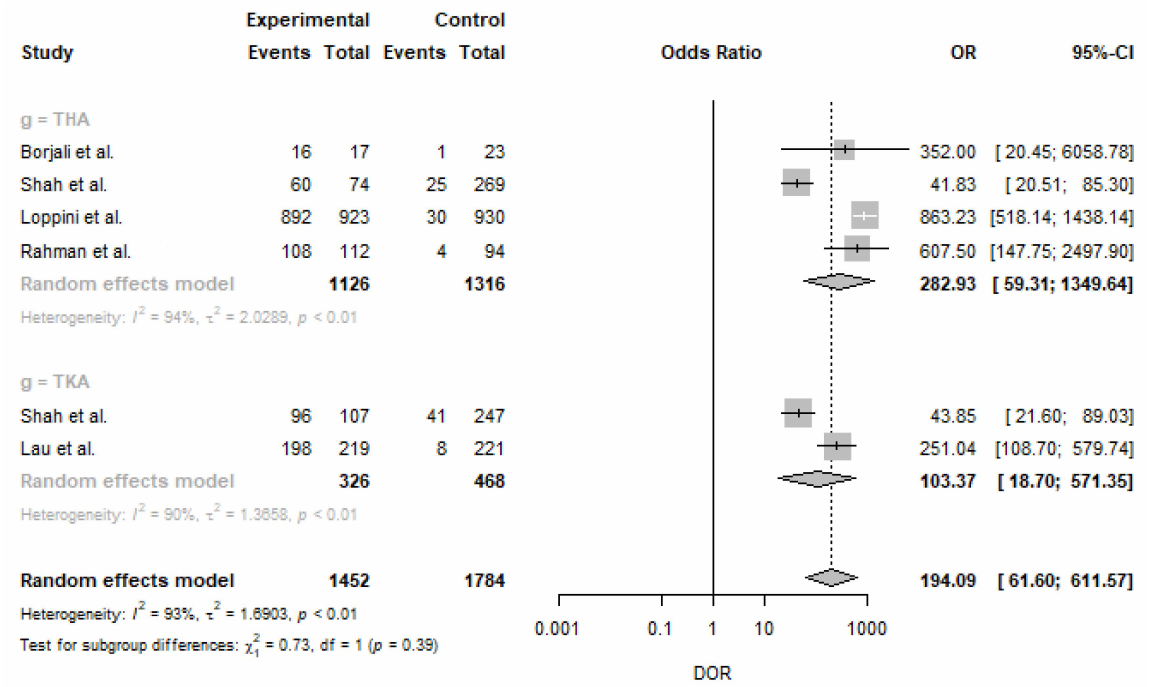
Medicina 2023 , 59 , x FOR PEER REVIEW Figure 3. Forest plots diagnostic odds ratio. IV: interval variance; CI: confidence interval, THA: total hip arthroplasty; TKA: total knee arthroplasty; DOR: diagnostic odds ratio [32–36].